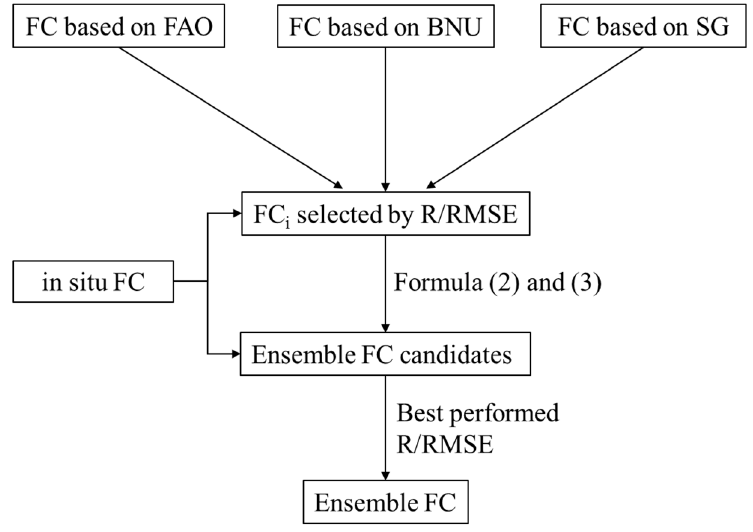
Figure 3. Algorithm for selecting field capacity ensemble members. FC represents field capacity.